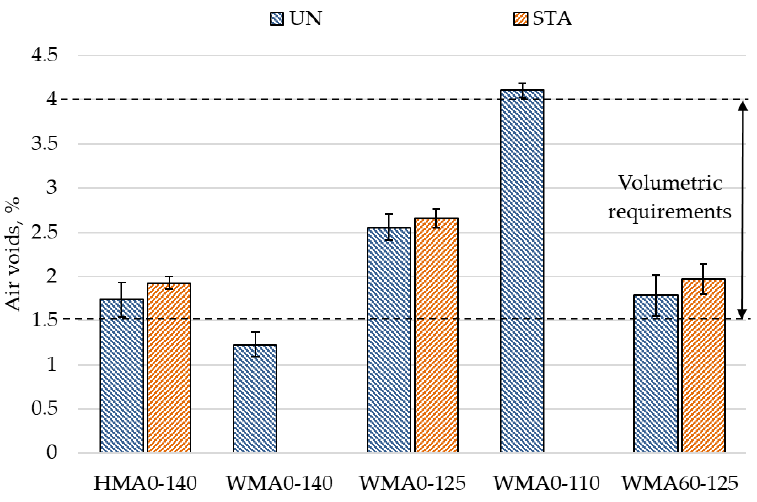
Figure 3. Volumetric analysis results.